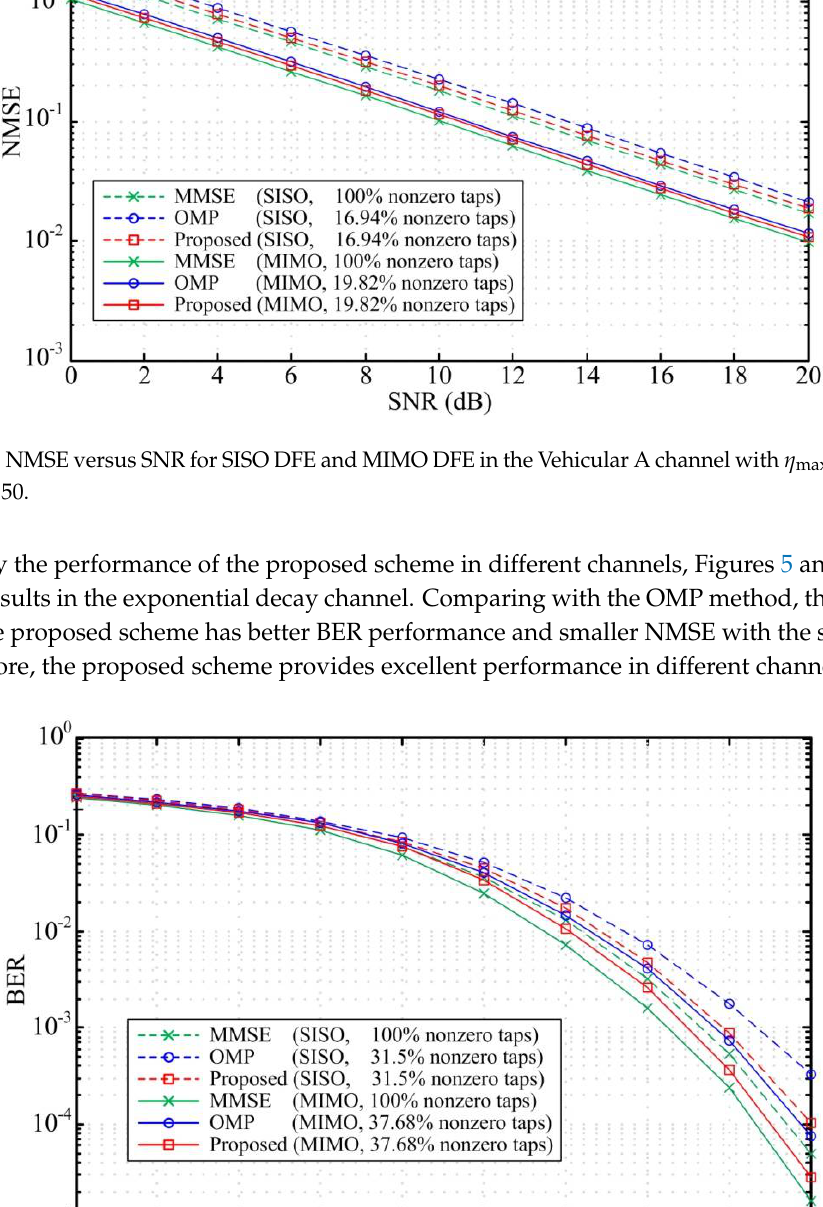
Figure 3. BER versus SNR for SISO DFE and MIMO DFE in the Vehicular A channel with max η = 0.6 dB and N f = 50.